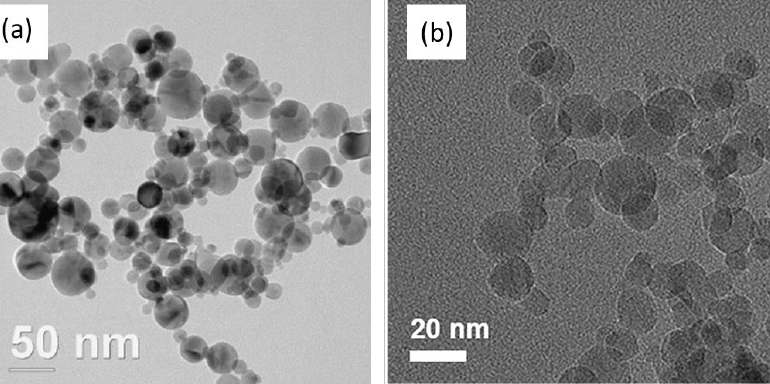
Figure 3. TEM images of TiO 2 FS products: ( a ) anatase – rutile with 3.6 mol.% WO x synthesized by conventional flame synthesis (Re-printed/adapted with permission from Ref. [78]. Copyright 2008, Elsevier); ( b ) mixed phases of anatase – rutile – TiO 2 -II synthesized from a laminar premixed stagnation flame (Re-printed/adapted with permission from Ref. [74]. Copyright 2018, American Chemical Society).